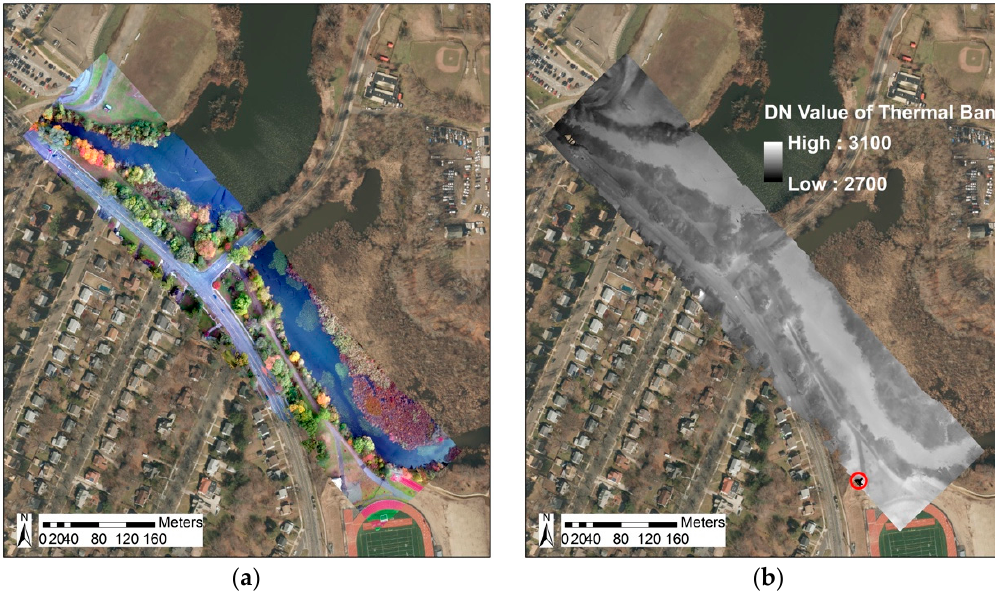
Figure 4. The georeferenced ( a ) RGB and ( b ) thermal orthomosaics of Beaver Pond Park. In the right panel, the legend is the main range of DN values of the thermal band. The red circle on the thermal orthomosaic indicates a black spot with an extremely low DN value (2250) due to the low-emissivity of a metal roof on a garage (identifiable on the RGB).